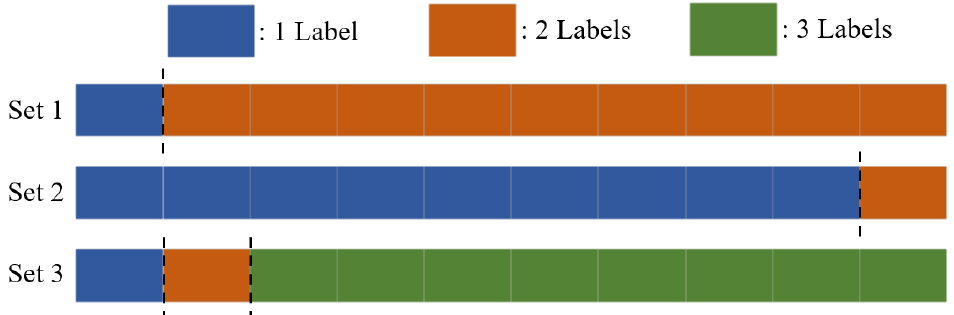
Figure 4. A graphical set of bars to show how to partition the entire dataset so that each client has an extreme data